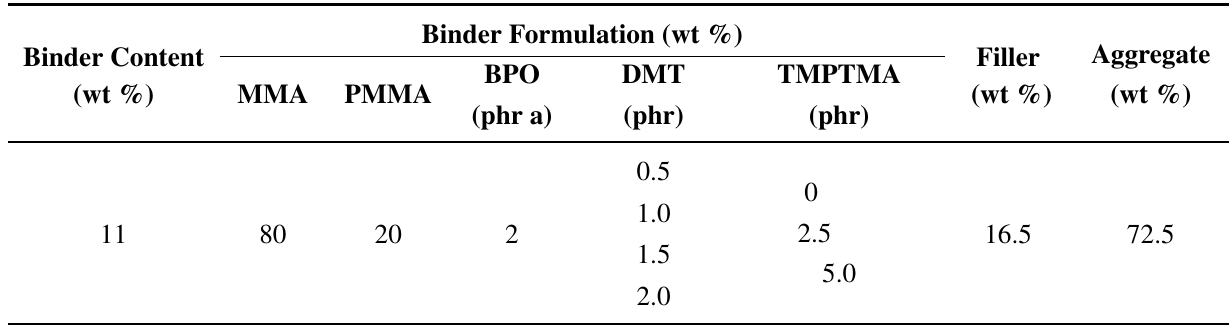
Table 2. Binder formulations and mixture proportions of acrylic polymer